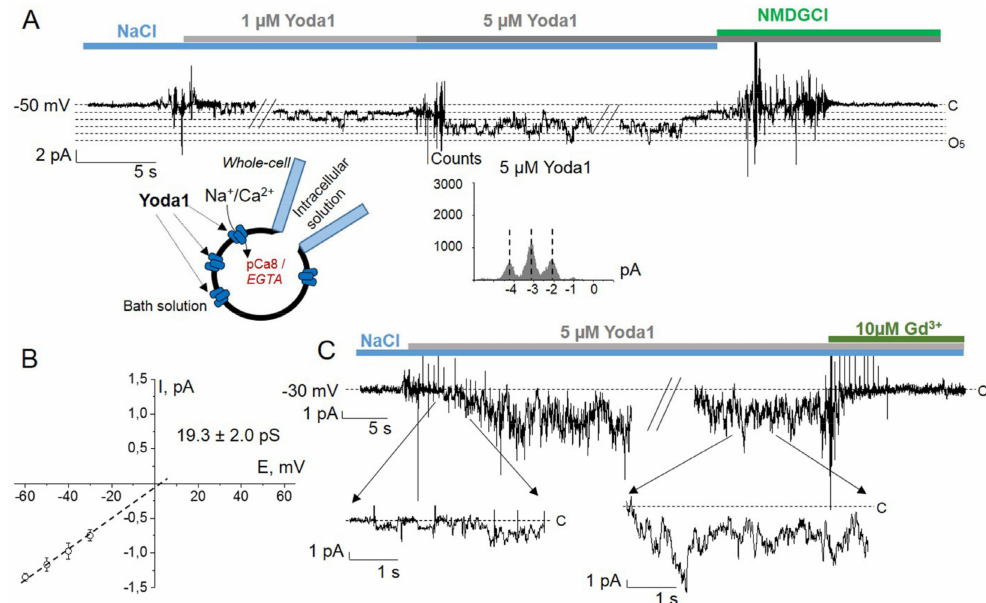
Figure 2. Single-channel recordings of Piezo1 activity in representative whole-cell experiments on K562 cells. ( A ) Ex- tracellular application of Yoda1 resulted in the activation of Piezo1 in the whole-cell membrane. The replacement of all permeable cations with non-permeable NMDG + resulted in the full abolition of Yoda1-induced ion currents. The amplitude histogram calculated for the particular current trace is presented below. Single-channel Piezo1 amplitudes could be clearly resolved between the centers of the peaks of the histograms. ( B ) The I-V relationship of Piezo1 channels. The mean unitary conductance of the channels is 19.3 ± 2.0 pS ( n = 5). ( C ) The development of a rather high level of Piezo1 activity in the whole-cell membrane in response to 5 µ M Yoda1 application. The parts of the traces indicated by arrows are shown in extended timescale. The following addition of MS channel blocker Gd 3+ (10 µ M GdCl 3 ) to the bath resulted in the